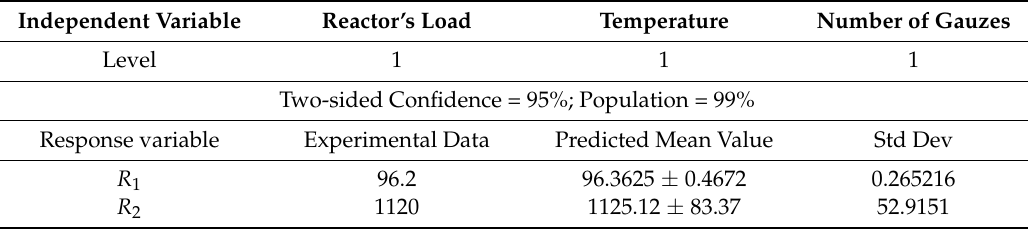
Table 8. The assumed levels of independent variables in validation studies and predicted responses